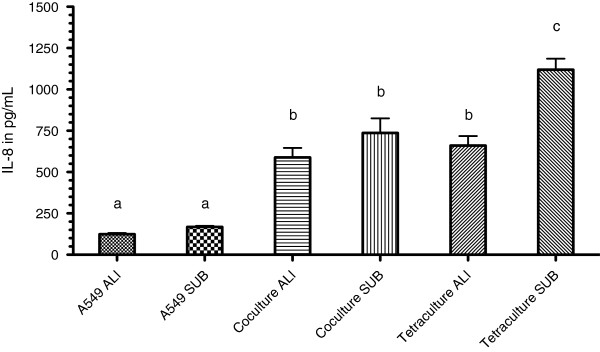
Evaluation of the levels of IL-8 after treatment with AAPH. Cultures were exposed to 20 mM AAPH in medium for 2 h. Afterwards samples of the undernatant were collected and analysed to evaluate the amounts of IL-8. Data represents the mean of at least four independent transwell inserts ± SEM. Groups that are sharing the same letters are not significantly different (P > 0.05).